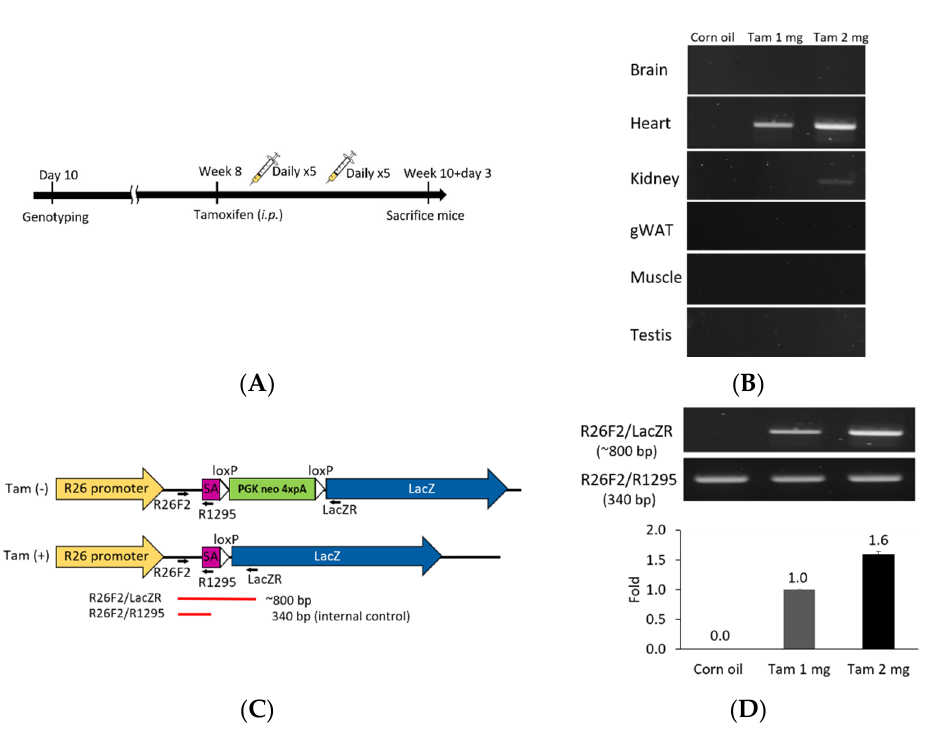
Figure 4. Tamoxifen induction Cre-loxP recombination of F1A-CreER T2 × ROSA26 F1 mice. (A) Eight-week old double-positive F1 mice were injected intraperitoneally with tamoxifen or corn oil vehicle control for 10 days within two weeks. The schematic flow is shown in ( A ). Tamoxifen was injected in eight-week old mice intraperitoneally with 100 μ L/mouse/day at 1 or 2 mg per mouse, during five consecutive days in a week, for a total of two weeks. ( B ) Tamoxifen-activated Cre-loxP recombination of genomic DNA PCR analysis of gene recombination. ( C ) The primers used for detection